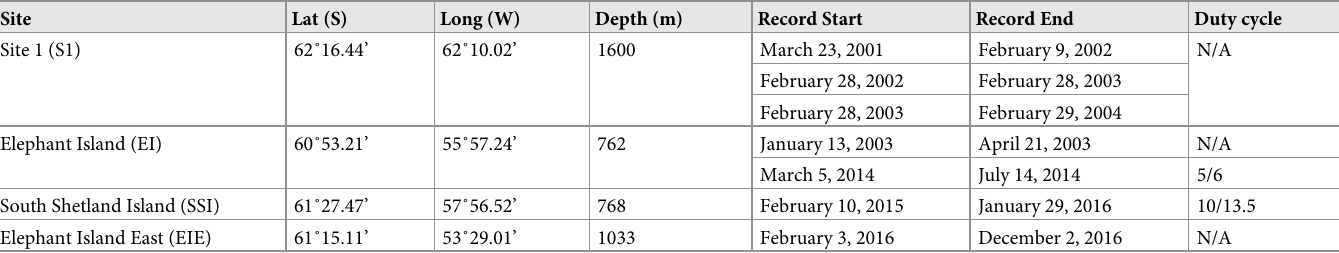
Table 1. Recorder deployment details.